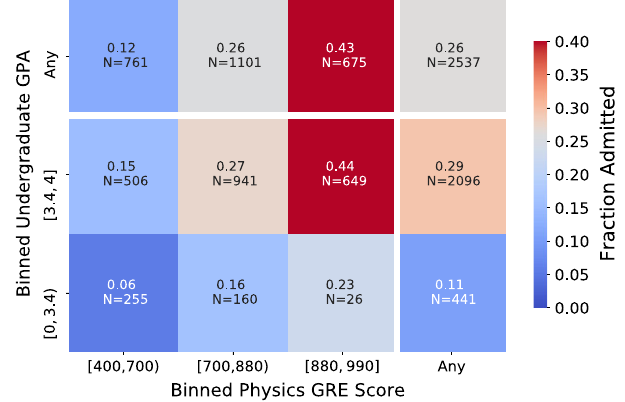
FIG. 15. A revised version of Fig. 4 showing the fraction of applicants admitted by undergraduate GPA and physics GRE score when the cutoff score for a high undergraduate GPA is 3.4.